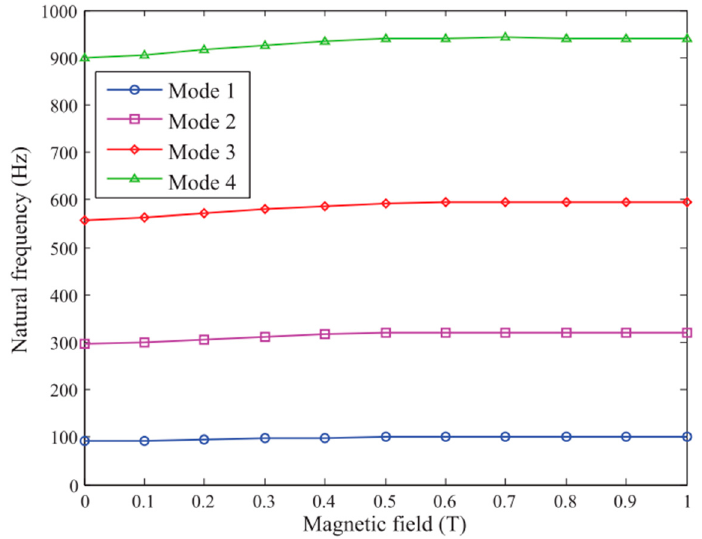
Figure 16. Natural frequency response under different magnetic fields [112].